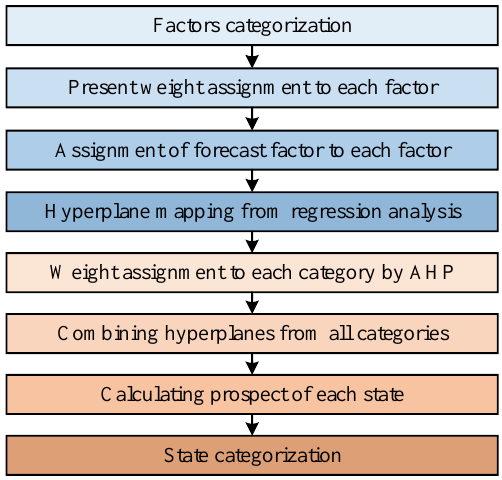
Figure 19. Methodology of work. After categorizing the factors, weights are assigned to each of them based on their positive or negative correlation with the growth of solar. Next, the hyperplanes are mapped, and, finally, the solar prospect of each state is calculated. Thus, the states are categorized into five